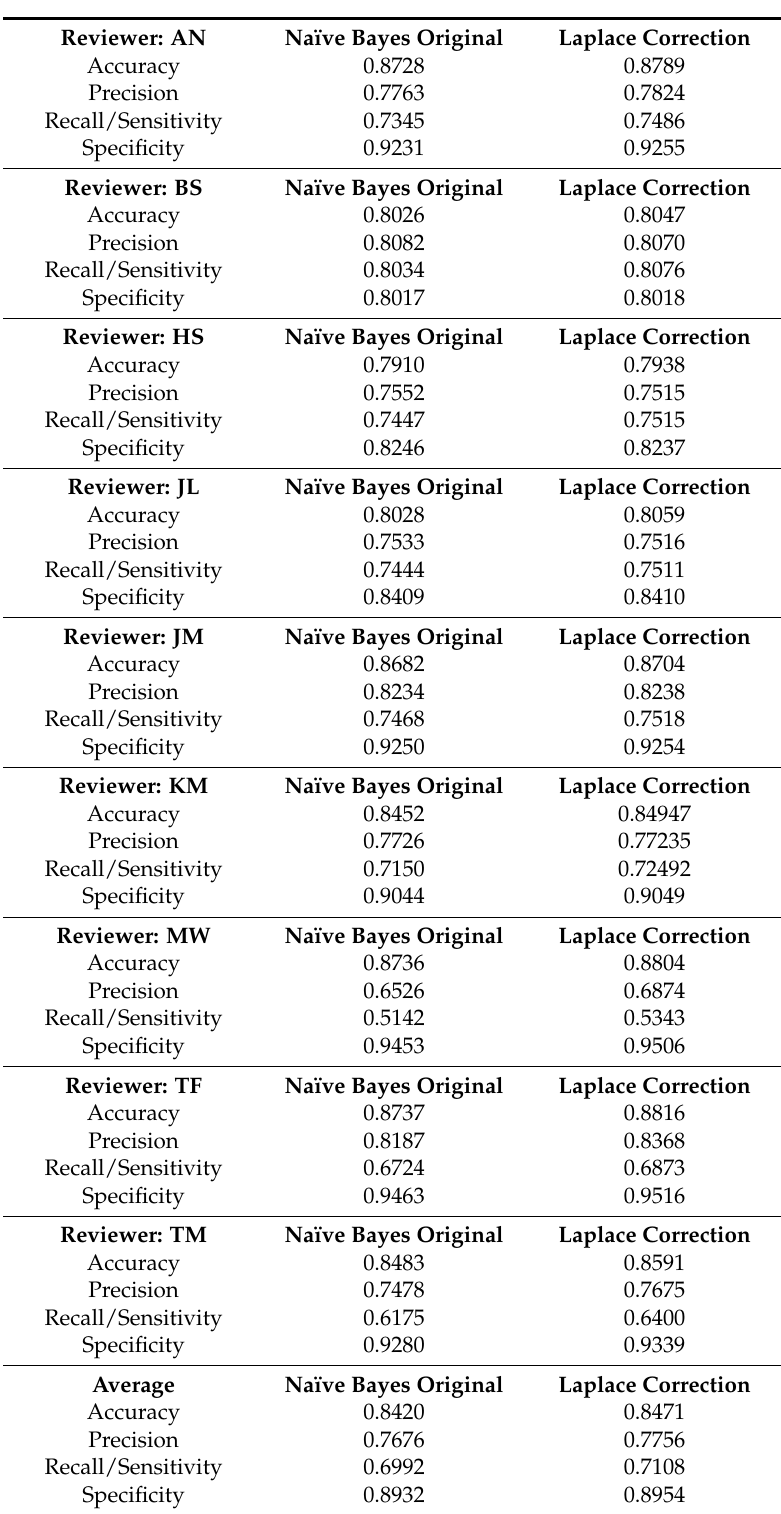
Table 4. Evaluation results for each wine reviewer based on Naïve Bayes algorithm with and without